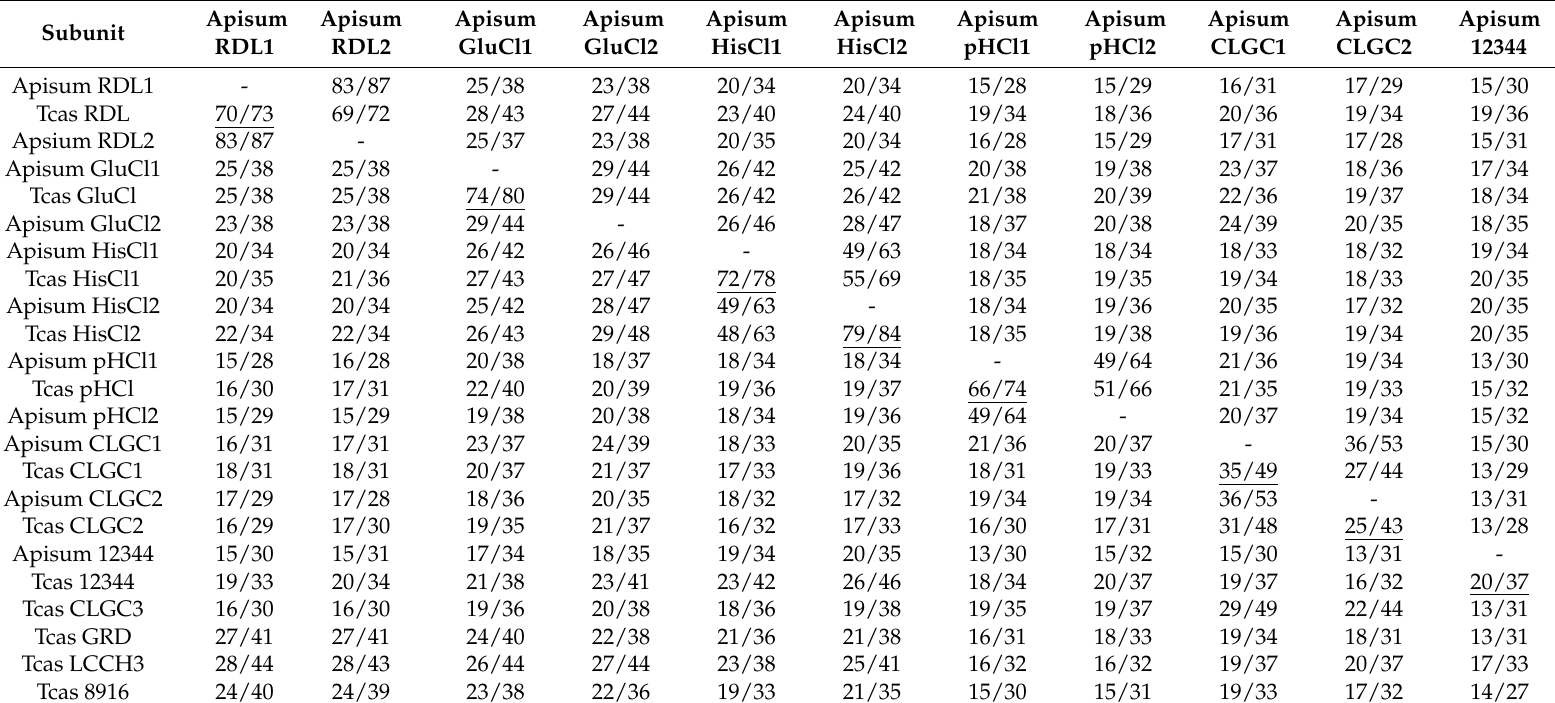
Table 1. Percentage identity/similarity between A. pisum and T. castaneum cysLGIC subunit protein